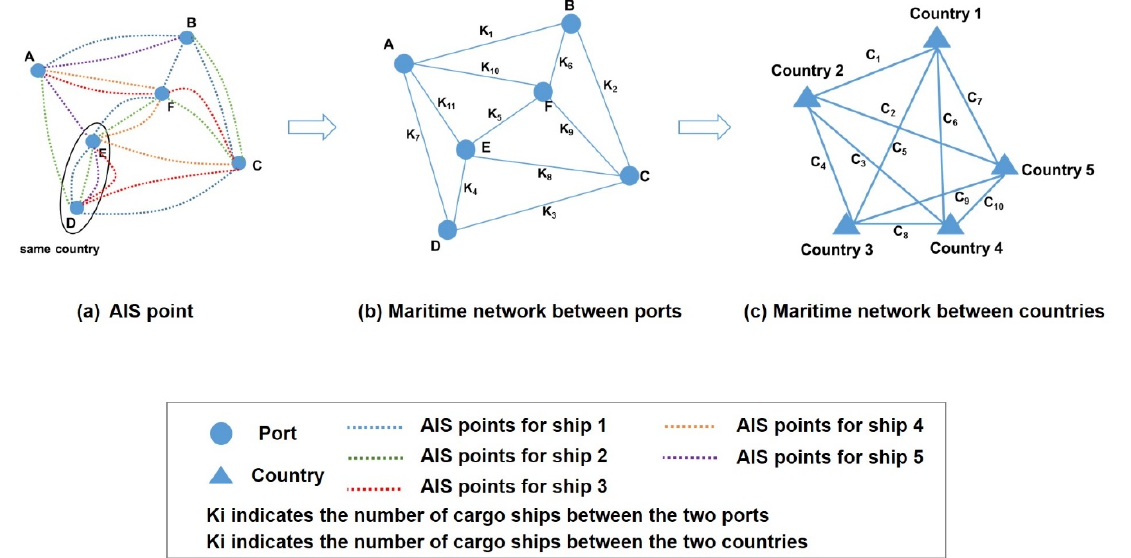
Figure 2. Construction of maritime network using AIS data: ( a ) Positioning different ships routes by real-time longitude and latitude information; ( b ) Identifying the ports in routes, and building a maritime network with ports as nodes; ( c ) Combining WPI and national basic information data to build a maritime network with countries as nodes. Source: Adapted from Yu et al. [35].